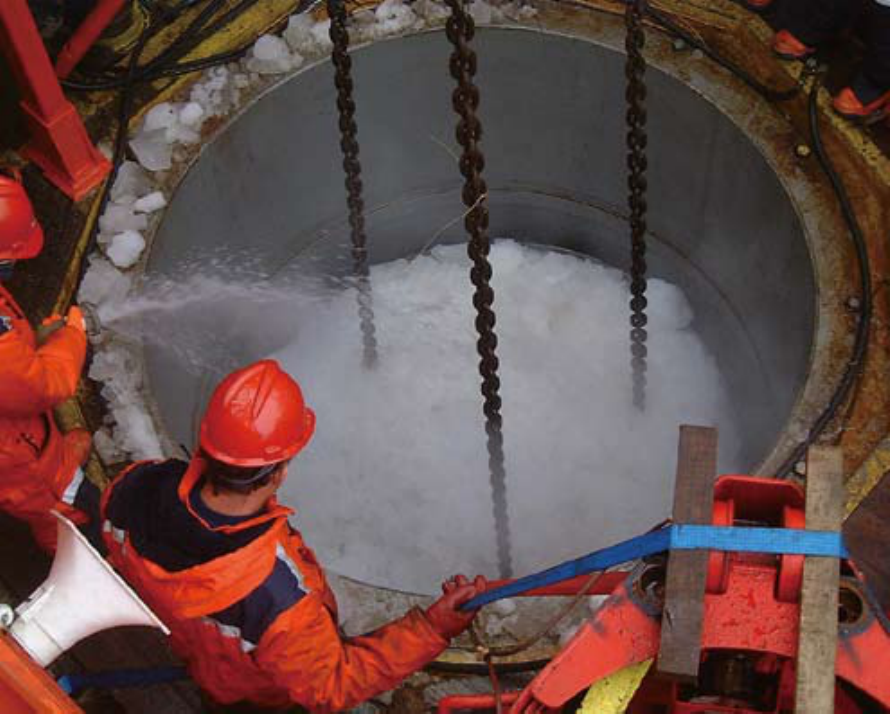
Figure 2. Clearing the moonpool to start work at the first